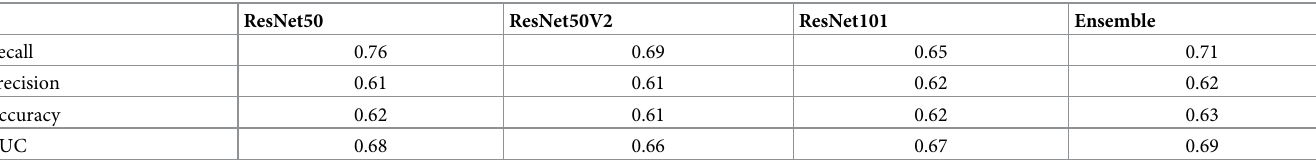
Table 4. Comparison of CNN models.